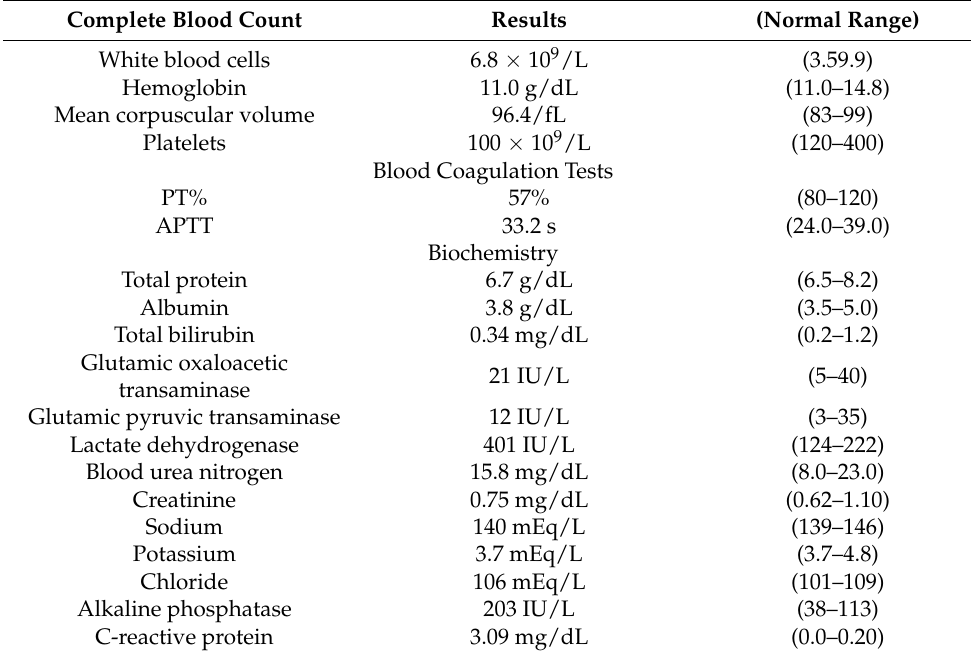
Table 1. Laboratory data of the patient on admission to the